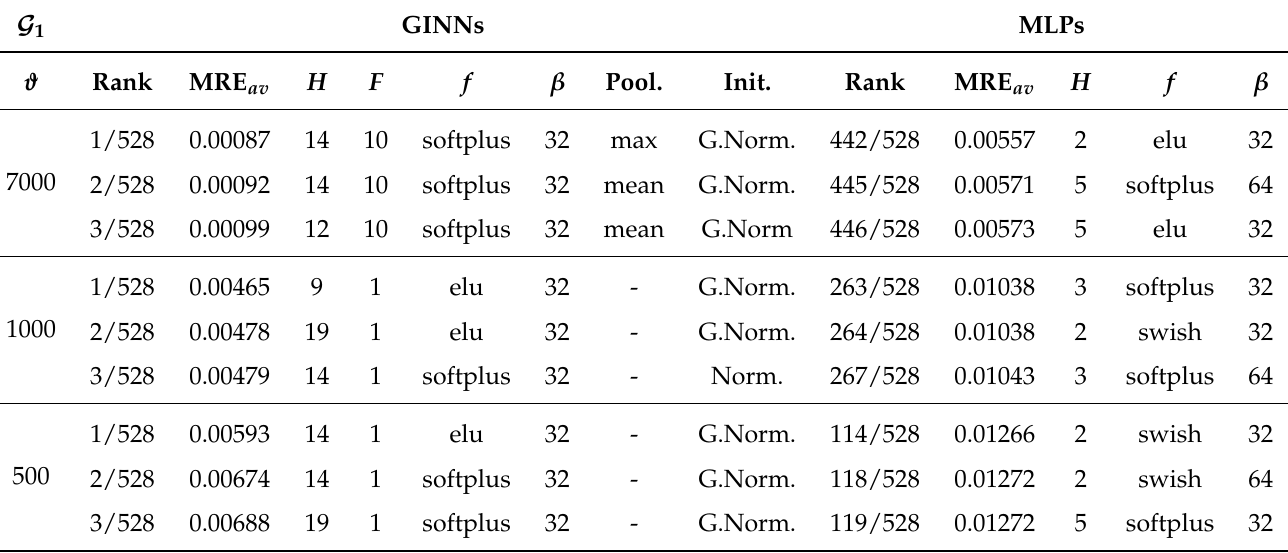
Table 2. Network . Top three GINNs and MLPs, for ϑ = 7000,1000,500. Models are sorted with G 2 respect to the MRE av error; the “rank” column describes their global position with respect to all the other